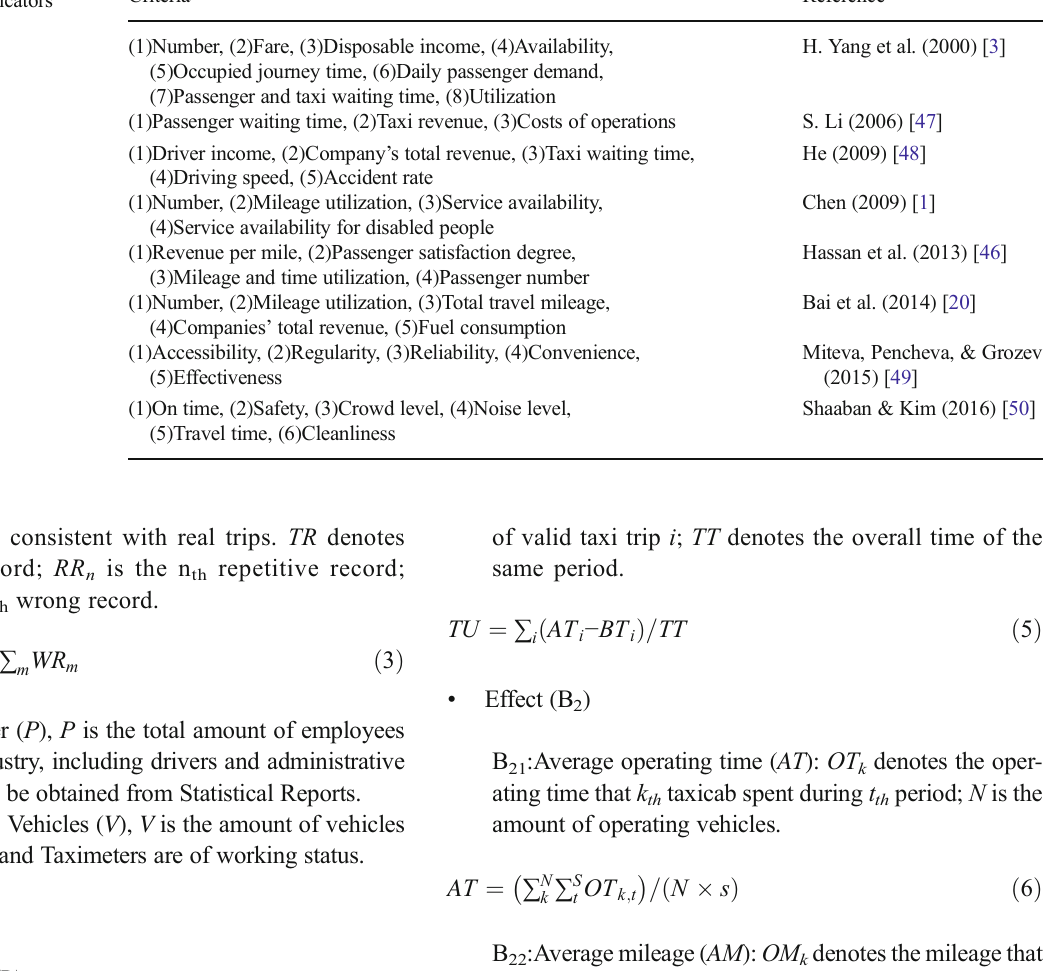
Table 2 Literature review of taxi industry evaluation indicators Criteria